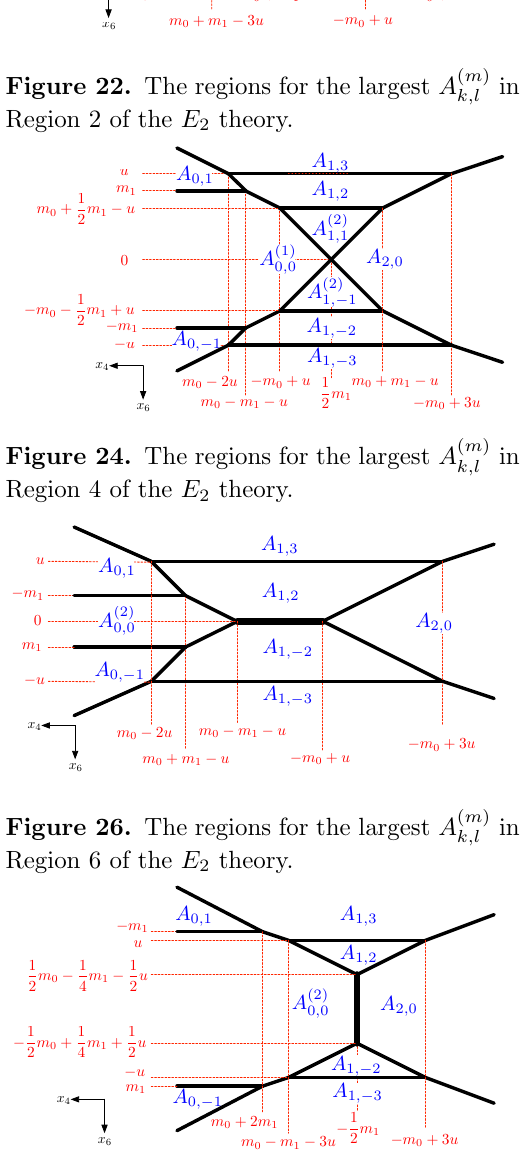
in Figure 28. The regions for the largest A ( m ) k;l Region 8 of the E 2